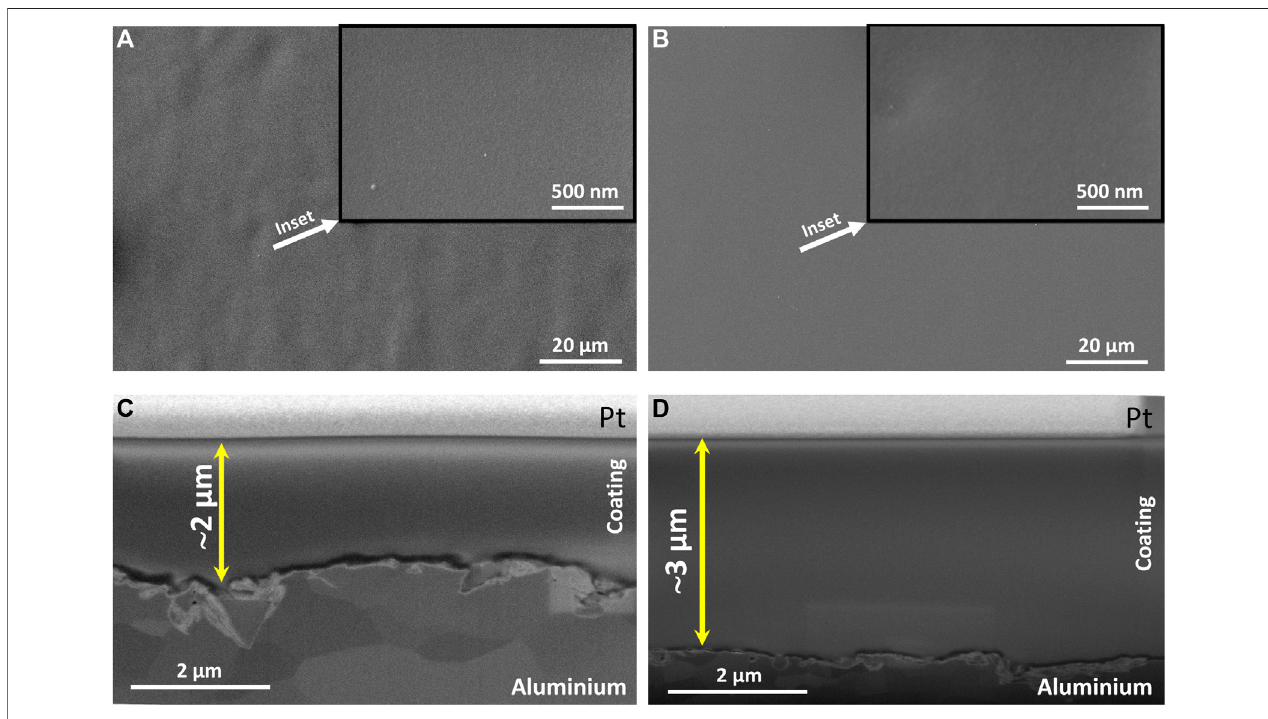
FIGURE 5 | (A) and (B) top-view SEM images of TM and TMZ coating at different magni fi cations (insets) deposited on the aluminium substrate. (C) and (D) SEM imagesof the cross-sections between TM and TMZ coatings and aluminium substrate. Cross-sections were prepared by FIB. SEM images were collected in SEI